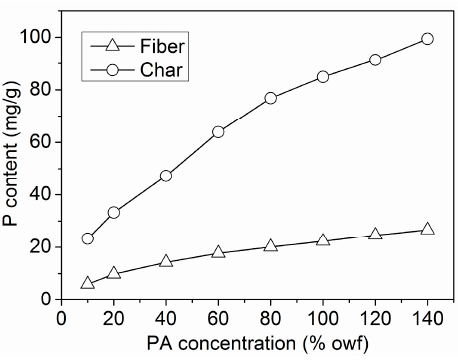
Figure 11. P content of wool fibers and corresponding char residues determined using ICP-OES.